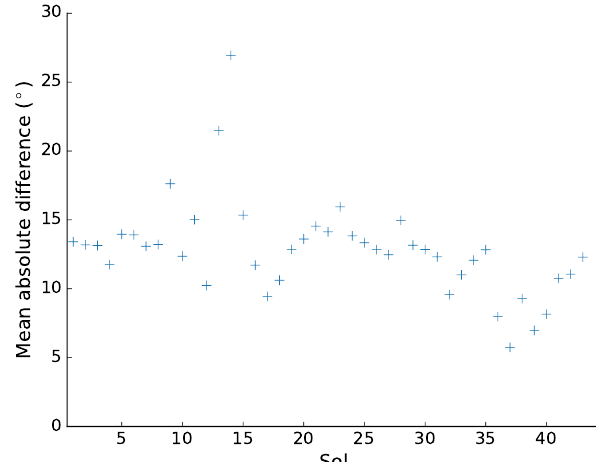
Figure 15. The distribution of R values during sols 46–377.